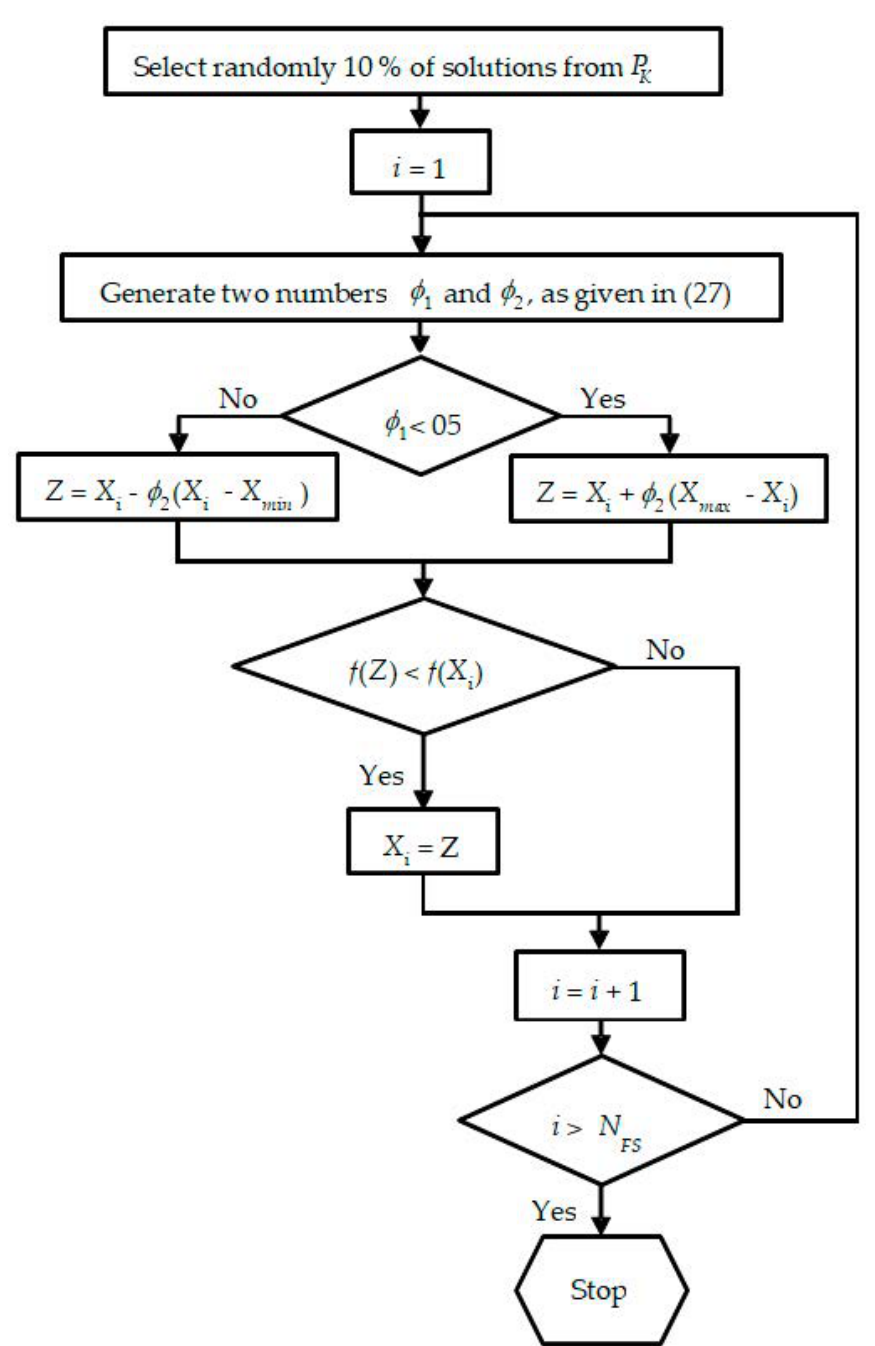
Figure 2. Chaotic-based local search. It is worth mentioning that the input parameters of the proposed algorithm are algo- rithm parameters and power network data such as cost coefficients, emission coefficients and B -loss coefficients. The outputs of the algorithm are the optimum generation of ther- mal units and wind farms, as well as minimum values of fuel cost and emissions. The pseudo-code of the improved ABC is shown in Algorithm